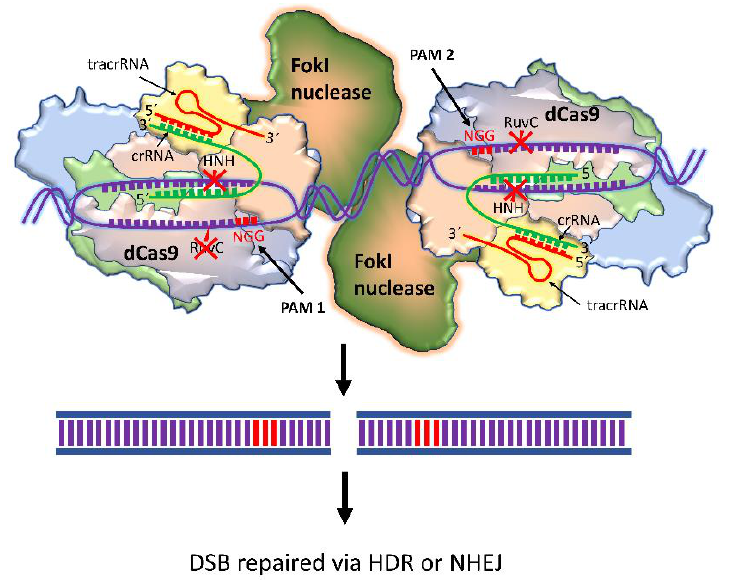
Figure 4. DNA cleavage by dCas9-FokI nuclease. FokI dimerization generates a double-stranded break at a specific sequence.